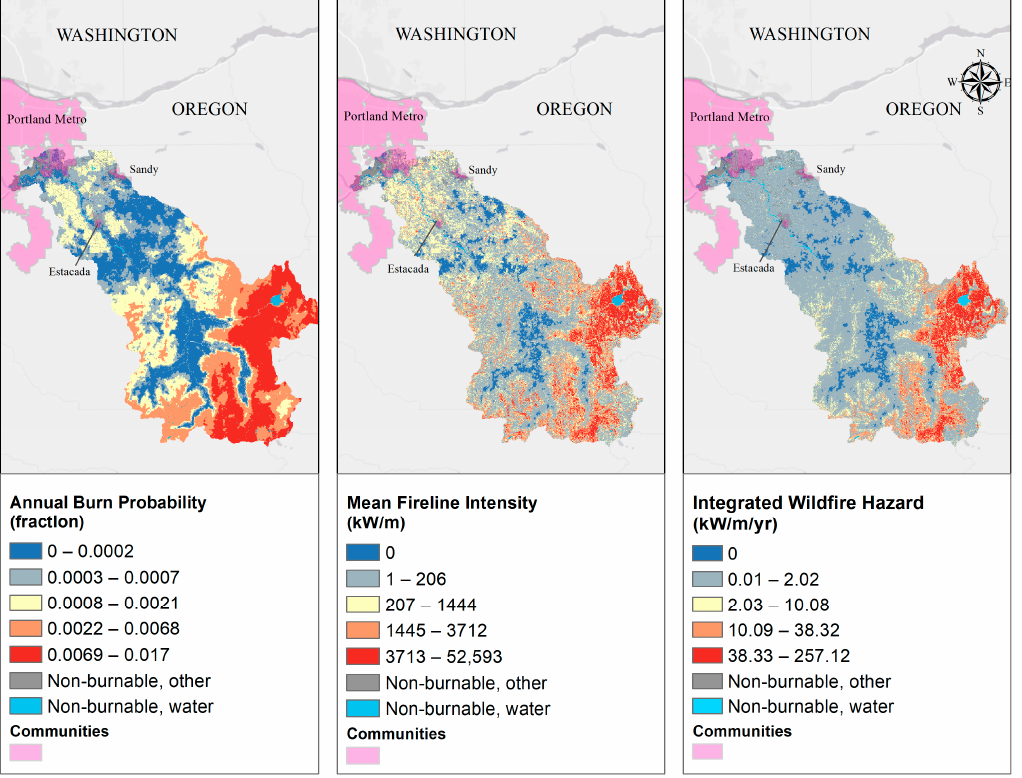
Figure 6. Wildfire behavior metrics under baseline conditions (1992–2015). Wildfire simulations produced maps of average annual burn probability ( left ) and mean fireline intensity ( center ) which, when multiplied, measure average wildfire hazard ( right ). Non-burnable pixels include water, barren land, development, and some types of